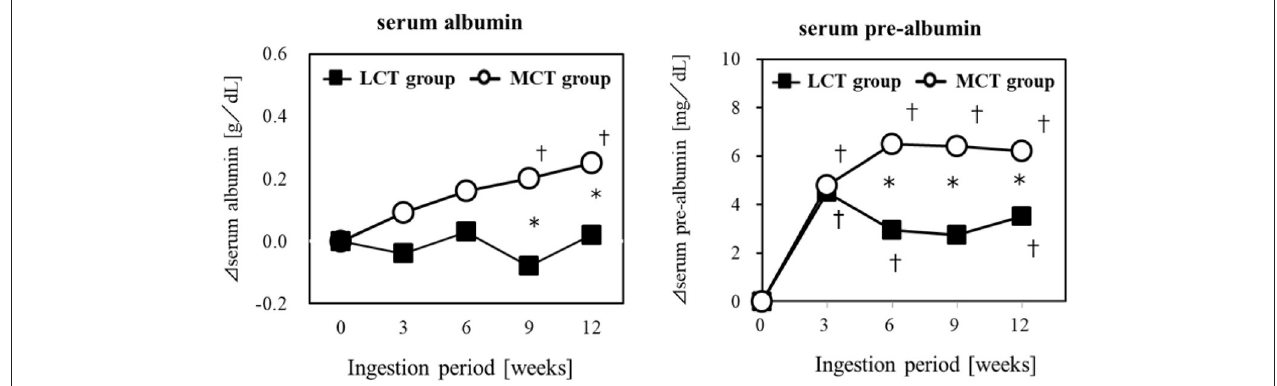
FIGURE 3 | Improvement of malnutrition by MCTs ingestion. Six gram/day of MCTs or LCTs in liquid form, divided into 2 doses/day. Ingested for 12 weeks in older adults (24 subjects) at high risk for malnutrition. *Significant difference between the groups ( p < 0.05). † Significant difference from the start ( p < 0.05).